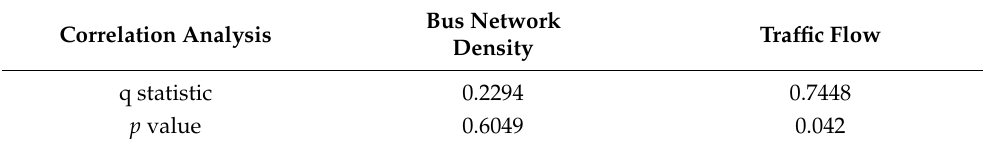
Table 7. Risk factor probe